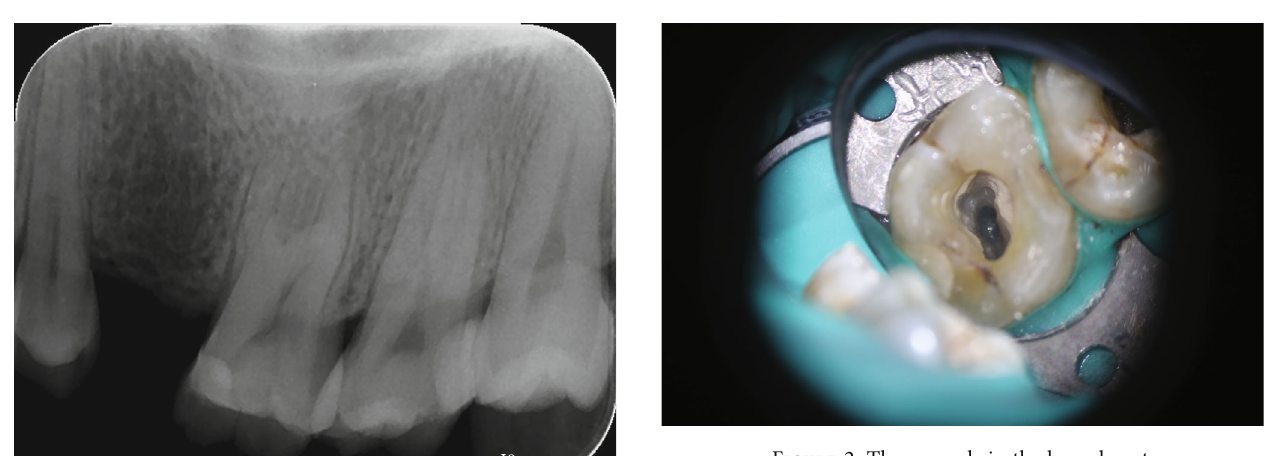
Figure 2: Three canals in the buccal